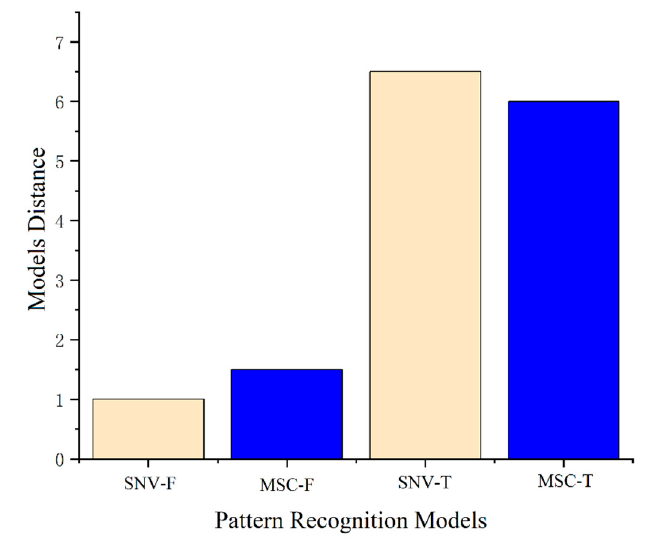
Figure 8. Distance graph between SIMCA classification models of Zhejiang and non-Zhejiang Ophi-